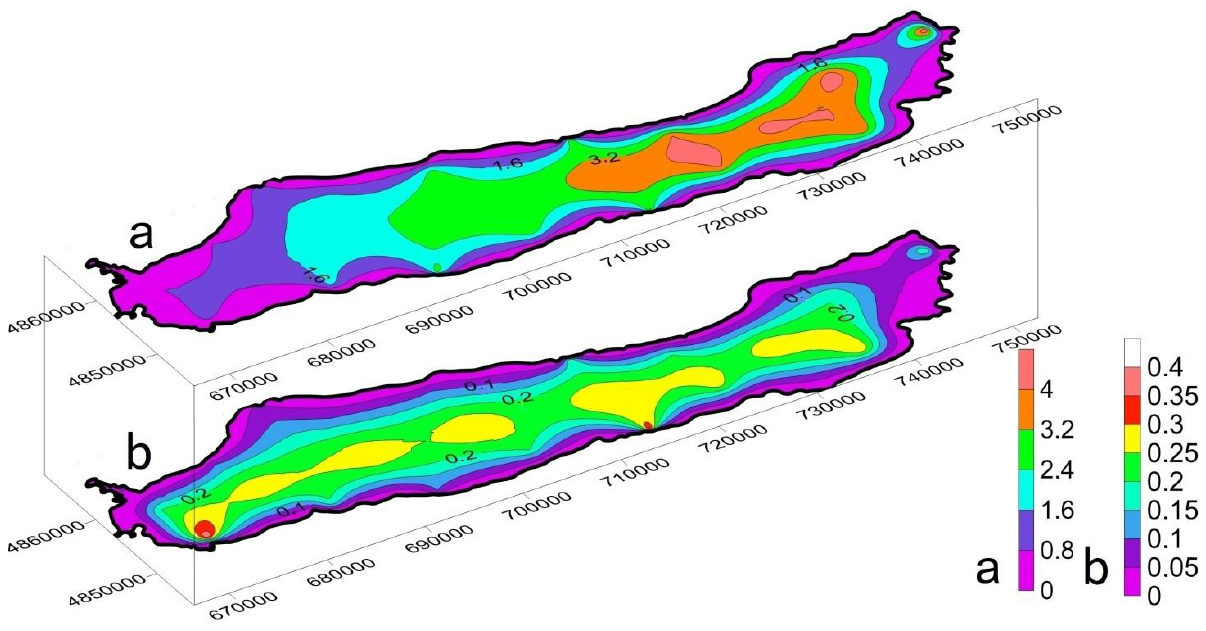
Figure 3. Spatial distribution of copper in water and bottom sediment of the Kapshagay Reservoir. ( a ) Water — µg/L, ( b ) bottom sediment — mg/kg. (authors Ismukhanova L.T., Madibekov A.S.).